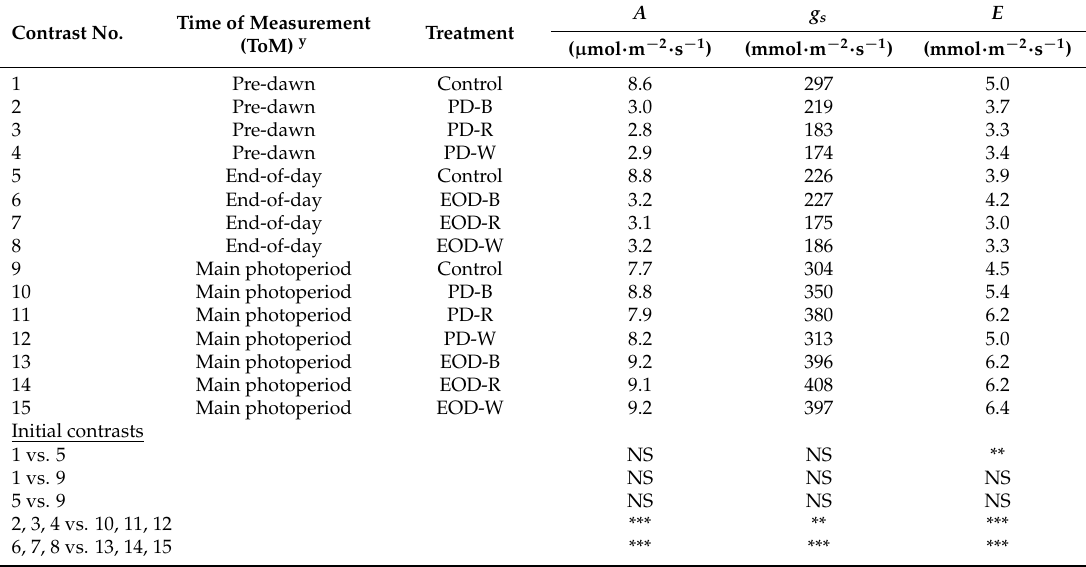
Table 2. Survey photosynthesis ( A ), stomatal conductance ( g s ), and transpiration ( E ) measured for lettuce plants grown in a controlled environment under one of seven light treatments z .